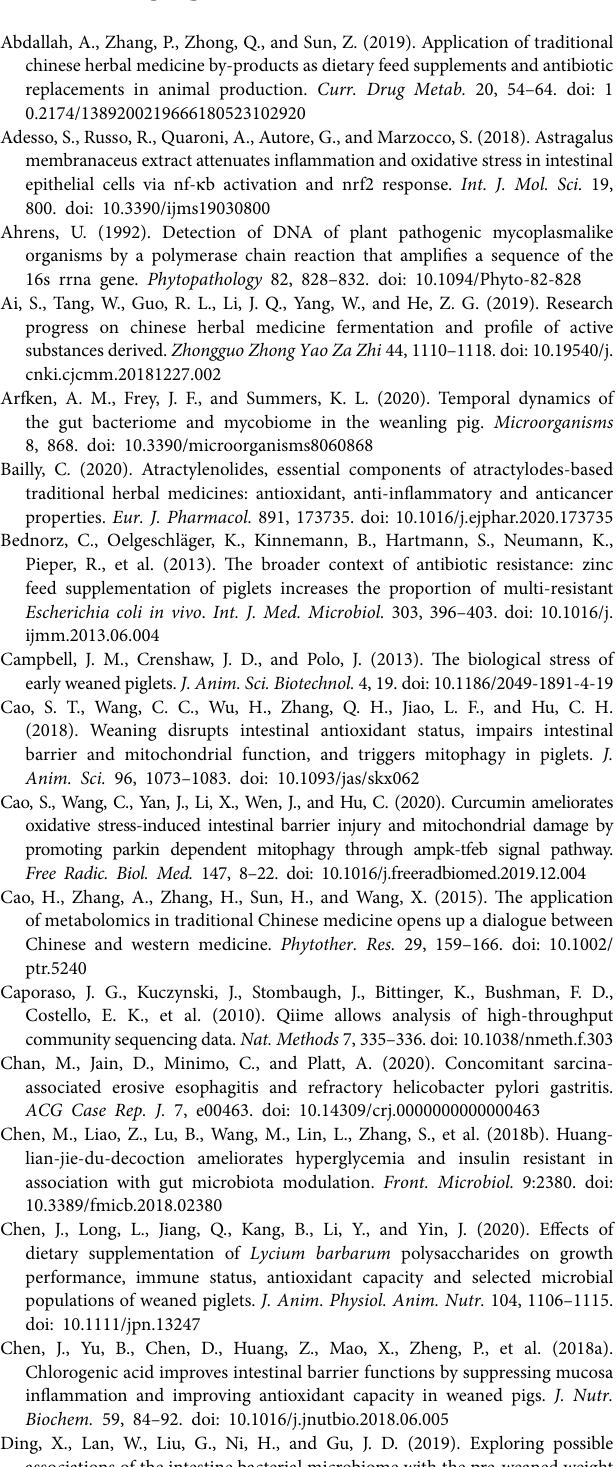
Supplementary Table S1 | Feed formula of different groups of piglets. Supplementary Table S2 | Formula nutrient values.